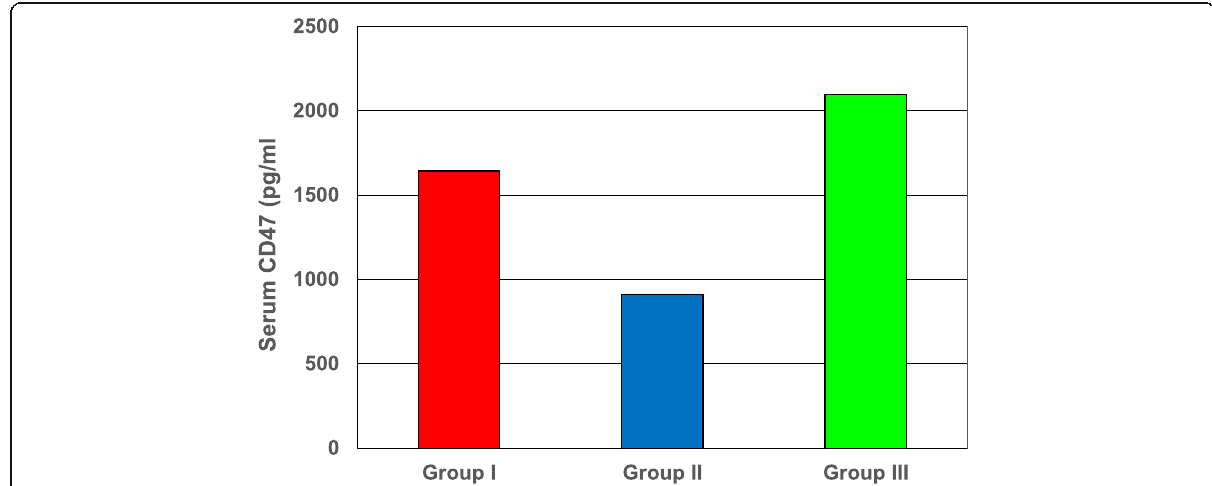
Fig. 5 Serum CD47 (pg/ml) in renal transplant recipients with stable allograft function (group I), chronic allograft dysfunction (group II), and in control subjects (group III)